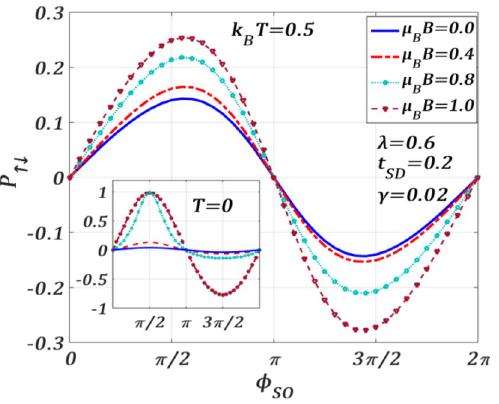
Figure 15. Spin-polarization P 0.5. Inset: at T k B T =